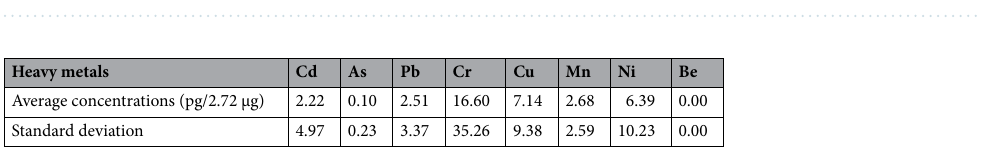
Figure 1. The experimental design of the study. Postnatal 8-week-old female Sprague–Dawley rats were administered nanoparticulate matter (diameter, 0.1–0.056 µm). Two behavioral tests, the olfactory sensitivity test and Y-maze test, were conducted before and after nasal instillation of nanoparticulate matter.